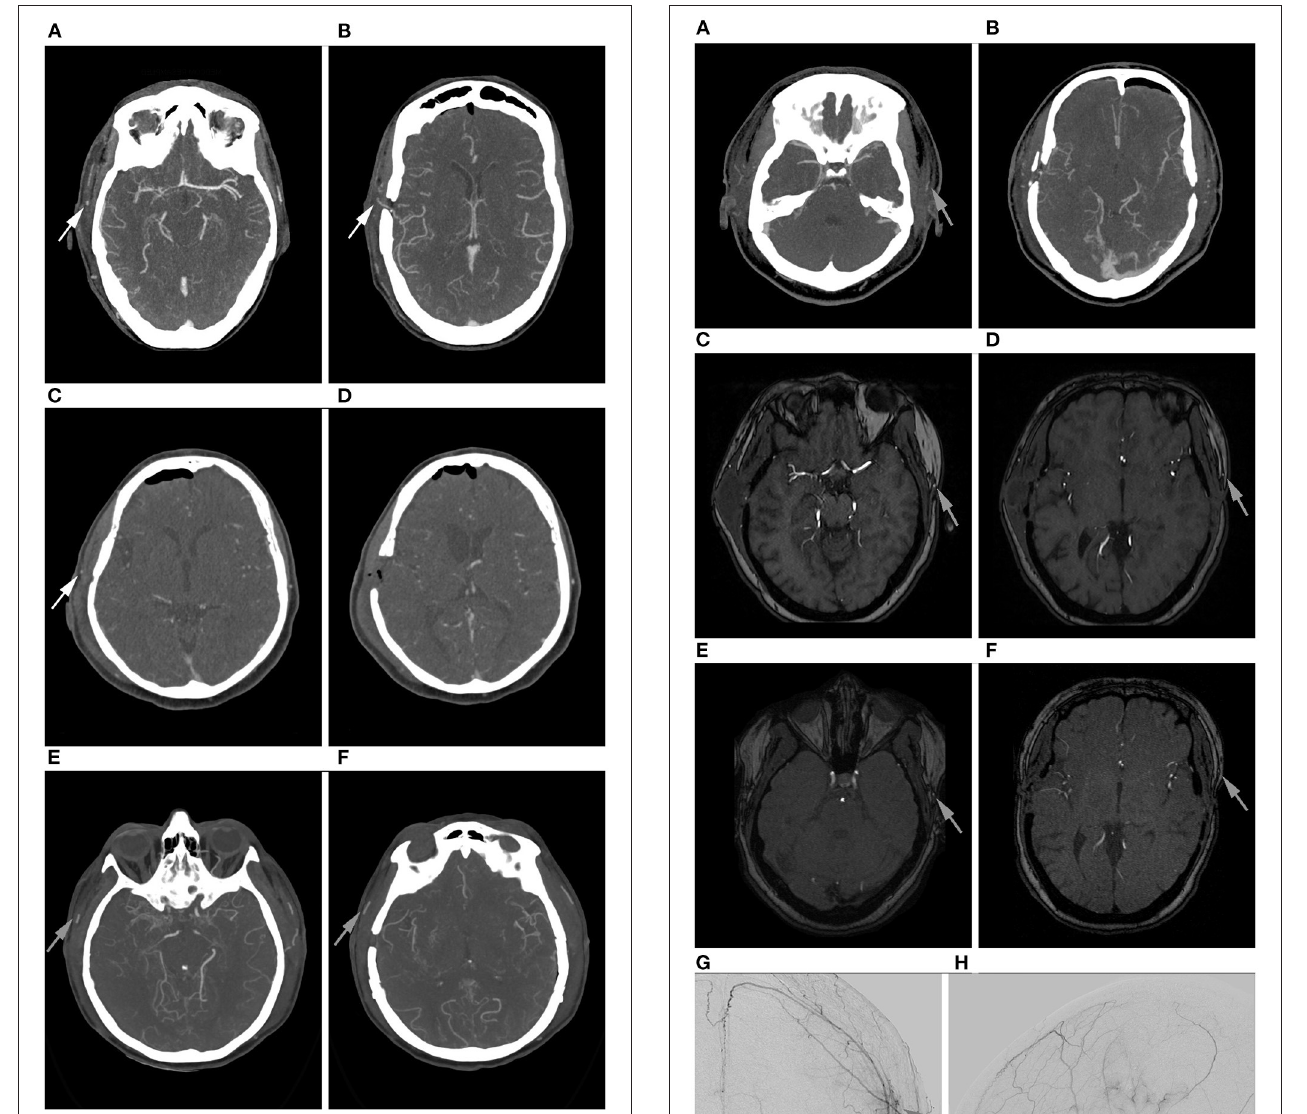
bypass to be truly patent in DSA when shown patent in CTA or MR-TOF) was